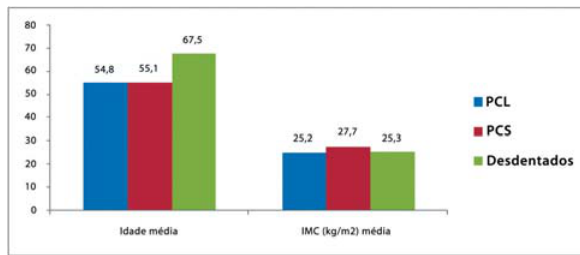
Fig. 2 - Características demográficas dos pacientes com doença coronariana com e sem periodontites crônicas. IMC = Índice de massa corporal; PCS = Periodontite crônica grave; PCL = Periodontite crônica leve